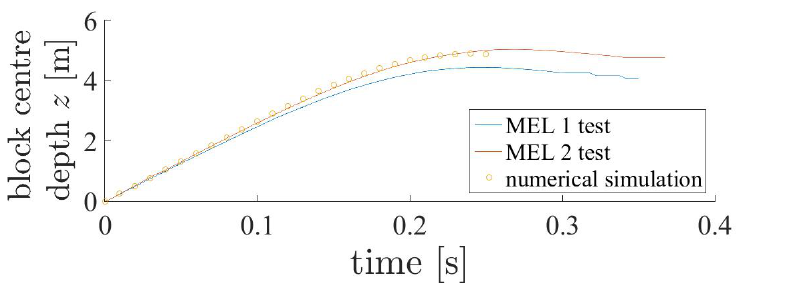
Figure 10. Displacement of the block centre as a function of time: MEL and numerical-test